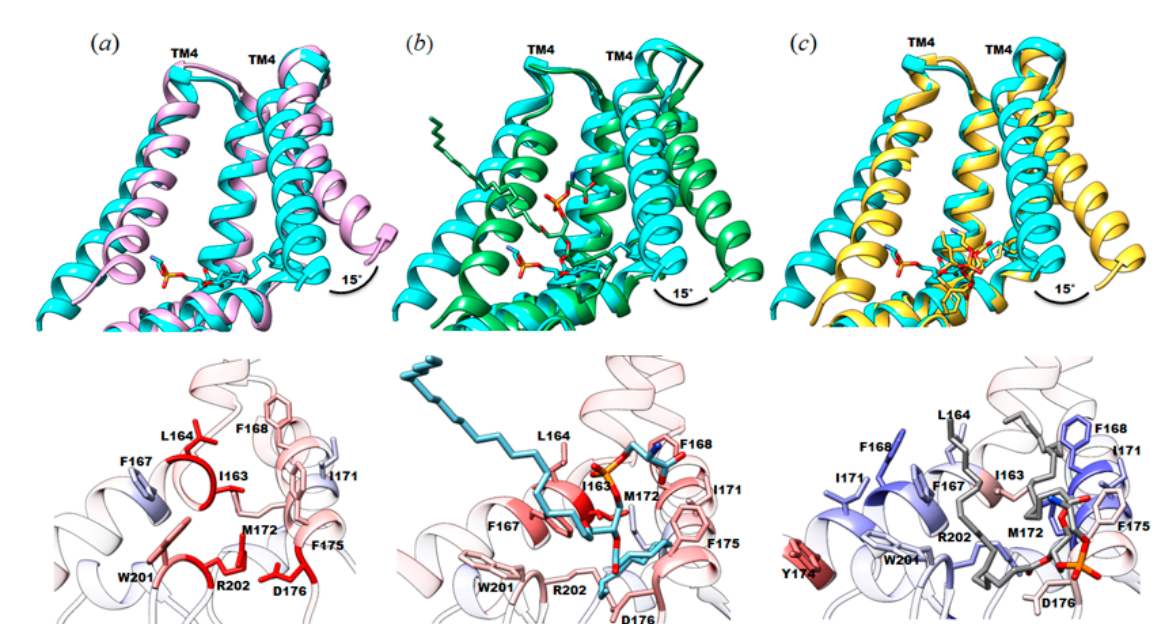
Figure 4. Structural comparison between the cryo-EM structure of SMA2000-YnaI with published structures focused on the protein-lipid interactions. Top, different orientation of TM4 between the SMA2000 structure (PDB ID: 7N4T, cyan) and ( a ) DDM structure reconstituted in amphipols (PDB ID: 5Y4O, purple); ( b ) LMNG structure (PDB ID: 6URT, green); and ( c ) DIBMA (PDB ID: 6ZYD, gold). Bottom, protein-lipid interactions comparison with specific amino acids colored by per-residue RMSD value. RMSDs less than 0.8 Å are shown in blue, RMSDs between 0.8 and 1.6 Å are shown in white, and RMSDs greater than 1.6 Å are shown in red.